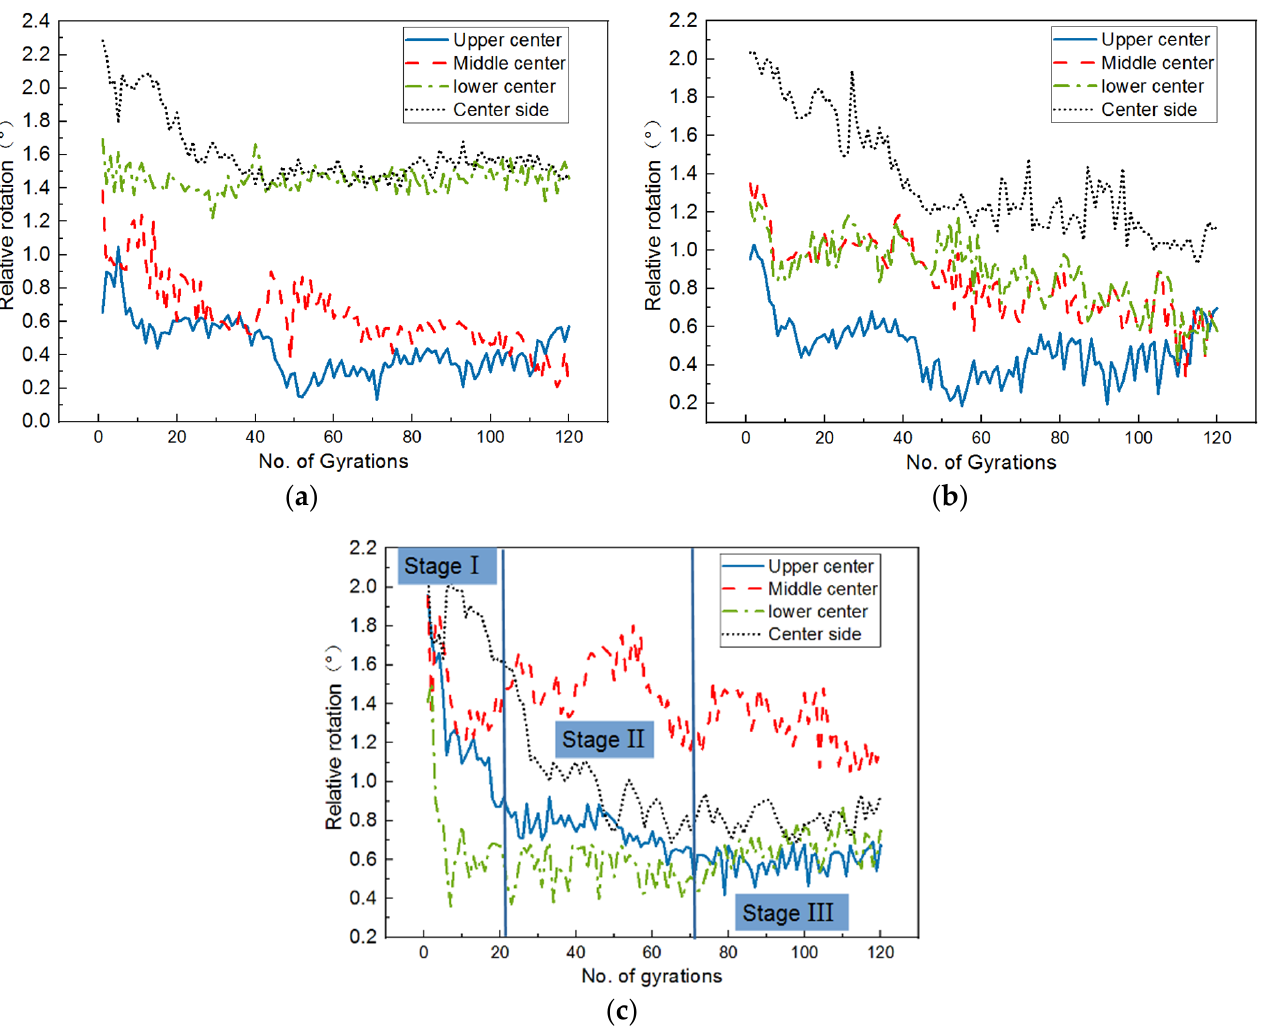
Figure 18. Relative rotation results measured at four different positions of the specimen with optimal combination of gyratory parameters: ( a ) X direction, ( b ) Y direction, and ( c ) Z direction.